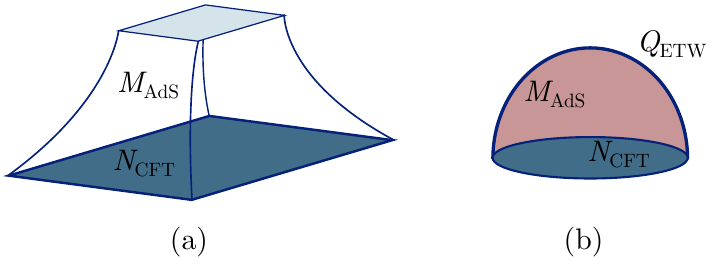
Figure 5 . (a) The AdS/CFT correspondence, with an asymptotically AdS bulk M AdS and an asymptotic boundary N CFT = ∂M AdS . (b) The AdS/BCFT correspondence. We add a boundary to the CFT, whose holographic “image” is the ETW brane Q